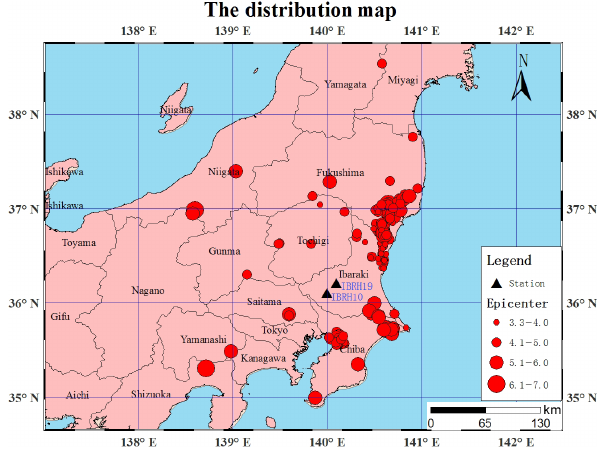
Figure 1. The station and epicenter distribution map used for this